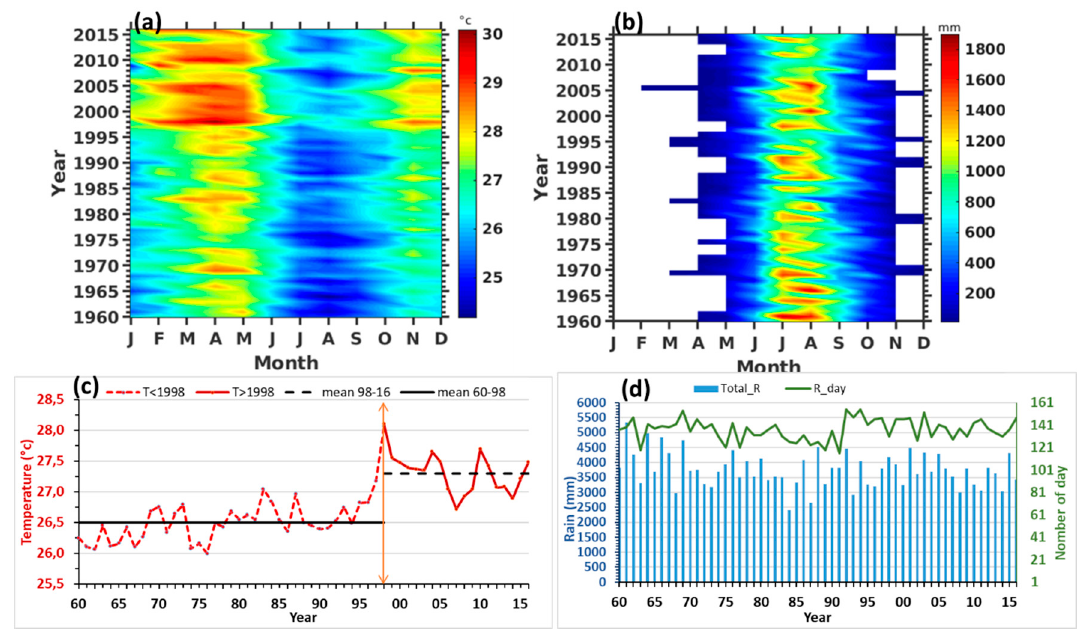
Figure 3. Yearly/monthly evolution of temperature ( a ) and rainfall with a pick during June-July-August ( b ); interannual evolution of temperature, dotted vertical line is the year 1998 ( c ) and interannual evolution of rainfall (blue bars) with rain day (black solid line) ( d ).